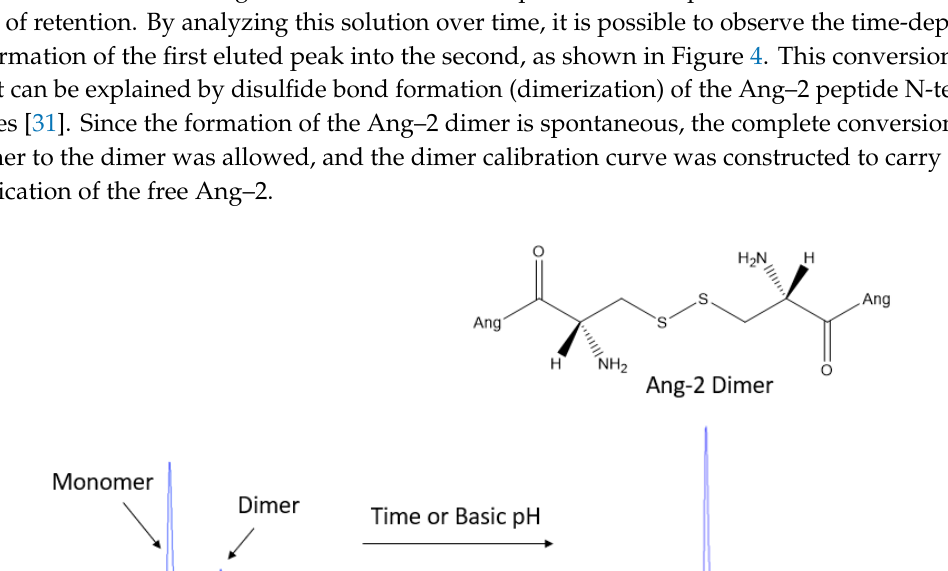
Table 1. Amount of Ang-2 bound to the nanoparticles determined through HPLC for three different PLGA-Mal/Ang-2 ratios. The controls correspond to nanoparticles with the same amount of Ang-2 as the experiment, but without the presence of PLGA-Mal. Values represent mean ± standard deviation ( n = 3 experiments). * and ** show statistically significant differences ( P < 0.05) between the label samples.